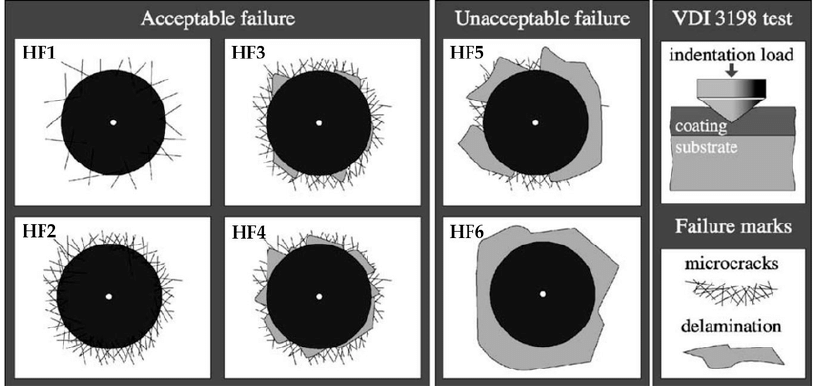
Figure 2. VDI 3198 indentation test.